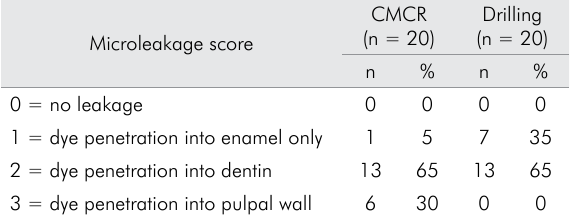
Table 1. Microleakage score according to comparison group.